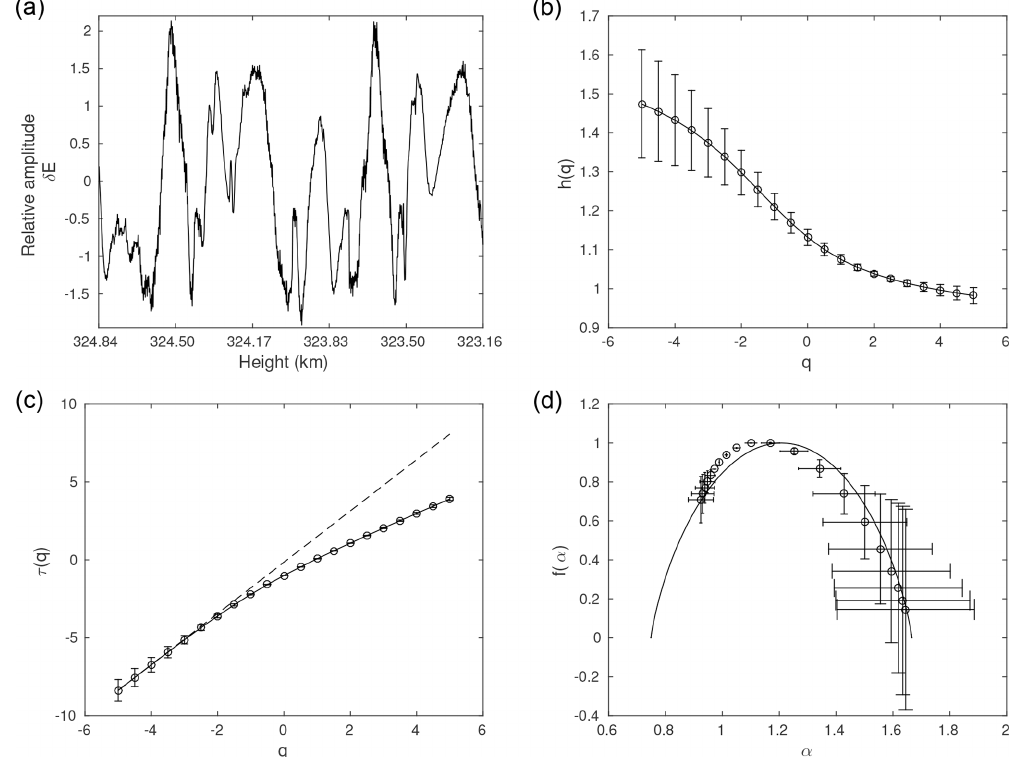
Figure 1. Comprehensive MFDFA for the first experiment: panel (a) shows the time series at mean height 324.00km and panel (b) shows the h(q) vs. q profile. Panel (c) shows τ(q) vs. q profile along with a dashed line which represents a linear relationship between τ(q) and q , and panel (d) shows the multifractal spectrum fitted with the p -model (continuous line).